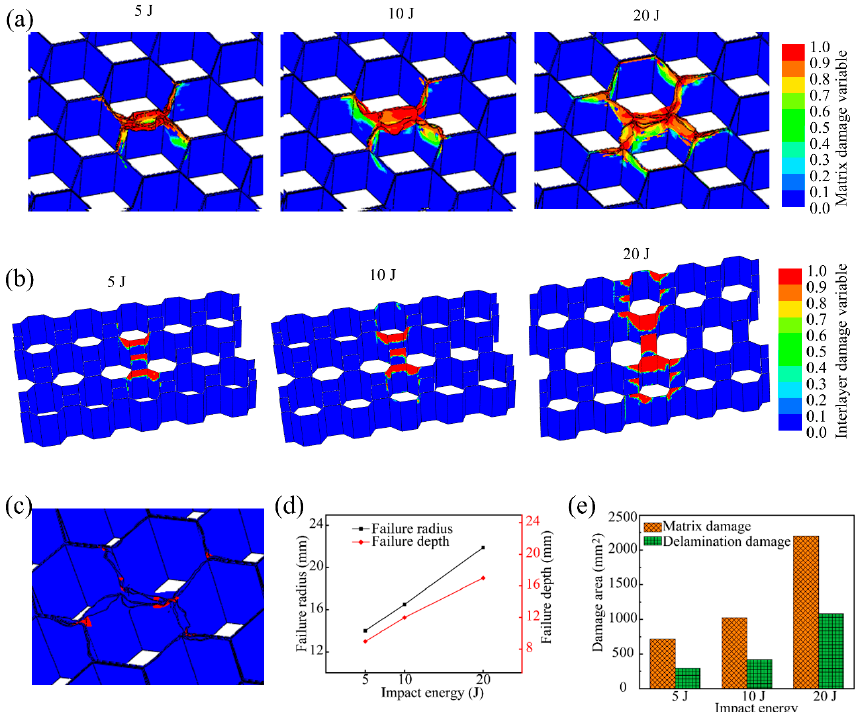
Figure 13. Impact damage of honeycomb core: ( a ) matrix damage variable near the center of honeycomb core, ( b ) delamination damage variable near the impact center of honeycomb core, ( c ) fiber fracture near the impact center of honeycomb core under 20 J of impact energy, ( d ) average failure radius and depth, and ( e ) area of matrix damage and delamination of honeycomb core.